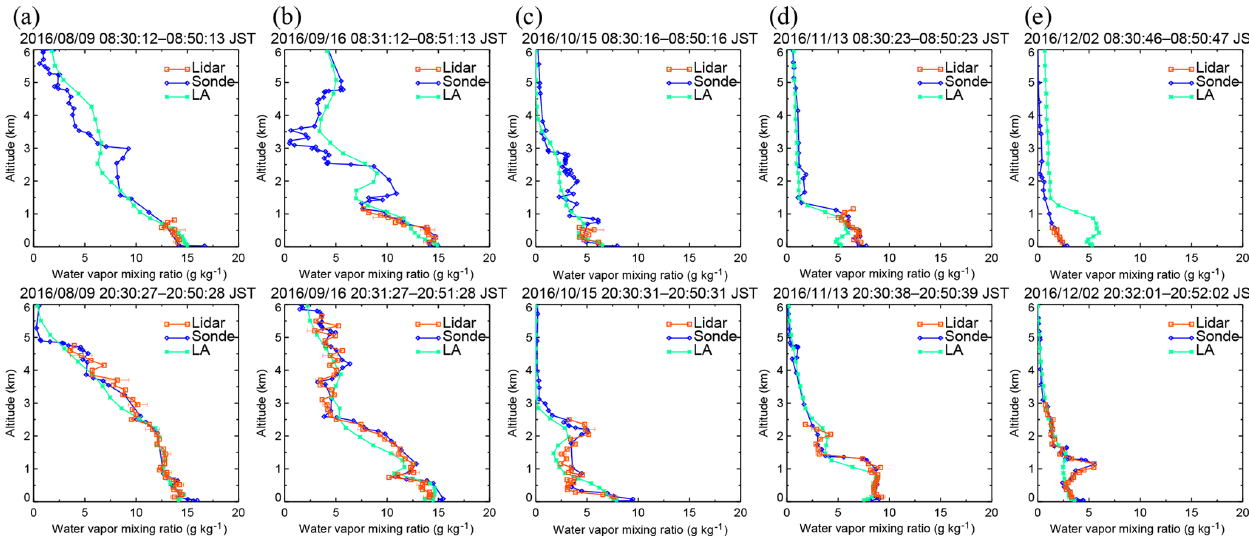
Figure 9. Vertical distributions of water vapor mixing ratios obtained with the MRL (orange) and radiosondes (blue) compared with local analysis data (green) for 08:30LST (upper panel) and 20:30LST (bottom panels) on (a) 9 August, (b) 16 September, (c) 15 October, (d) 13 November, and (e) 2 December 2016.